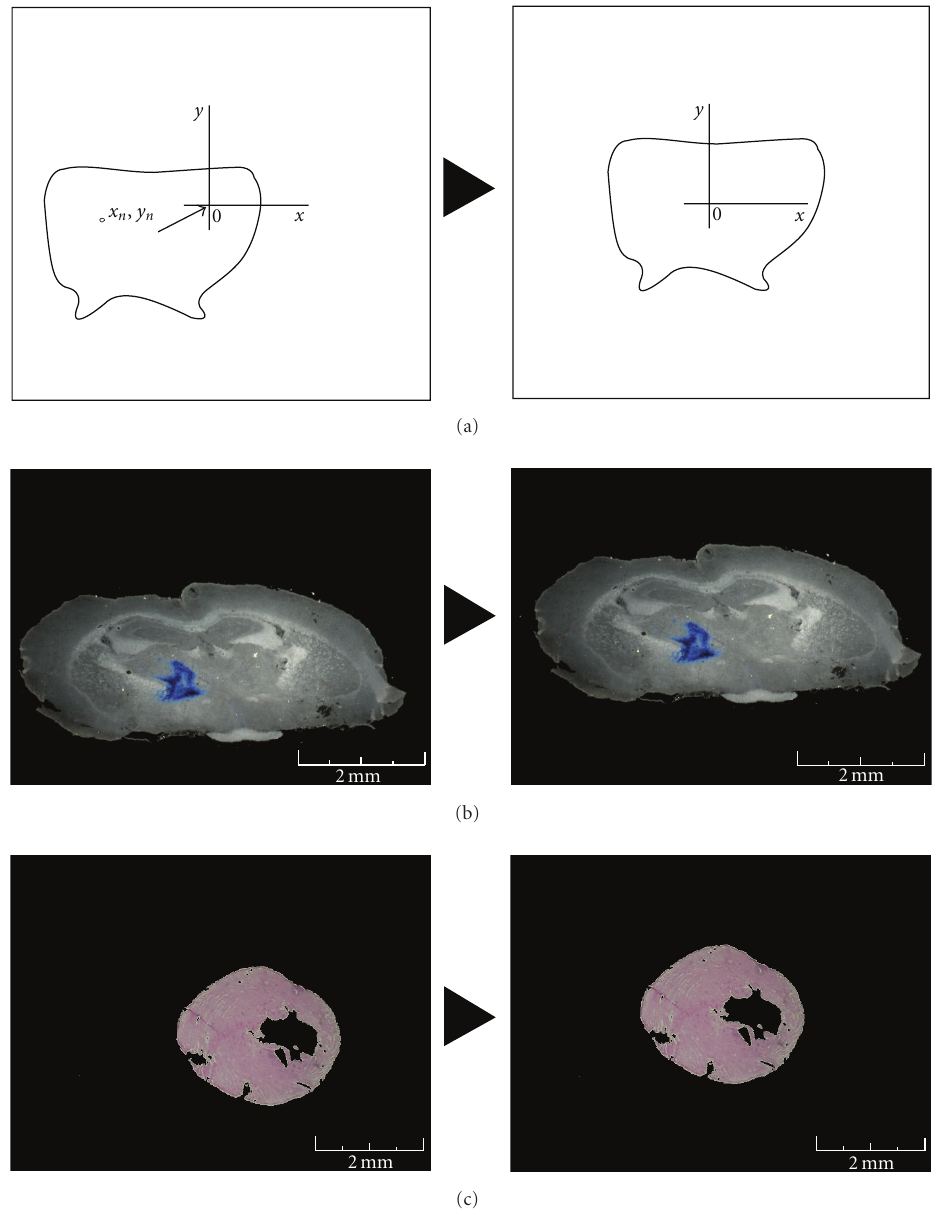
Figure 2: Woven image centre. (a) Outline (the reported image doesn’t represent any specific tissue section) of the image centring routine (see routine 1). x n and y n are coordinates of not black pixels (not RBG 0,0,0), x 0 and y 0 are the centre of the bitmap coordinates. The program calculates a kind of barycentre of the woven area in the image and moves it to the centre of the bitmap. (b) Example of the image centring procedure: left panel is an original image of the coronal serial sections, right panel is the same image after the automatic woven centring. (c) Example of the image centring procedure for heart section